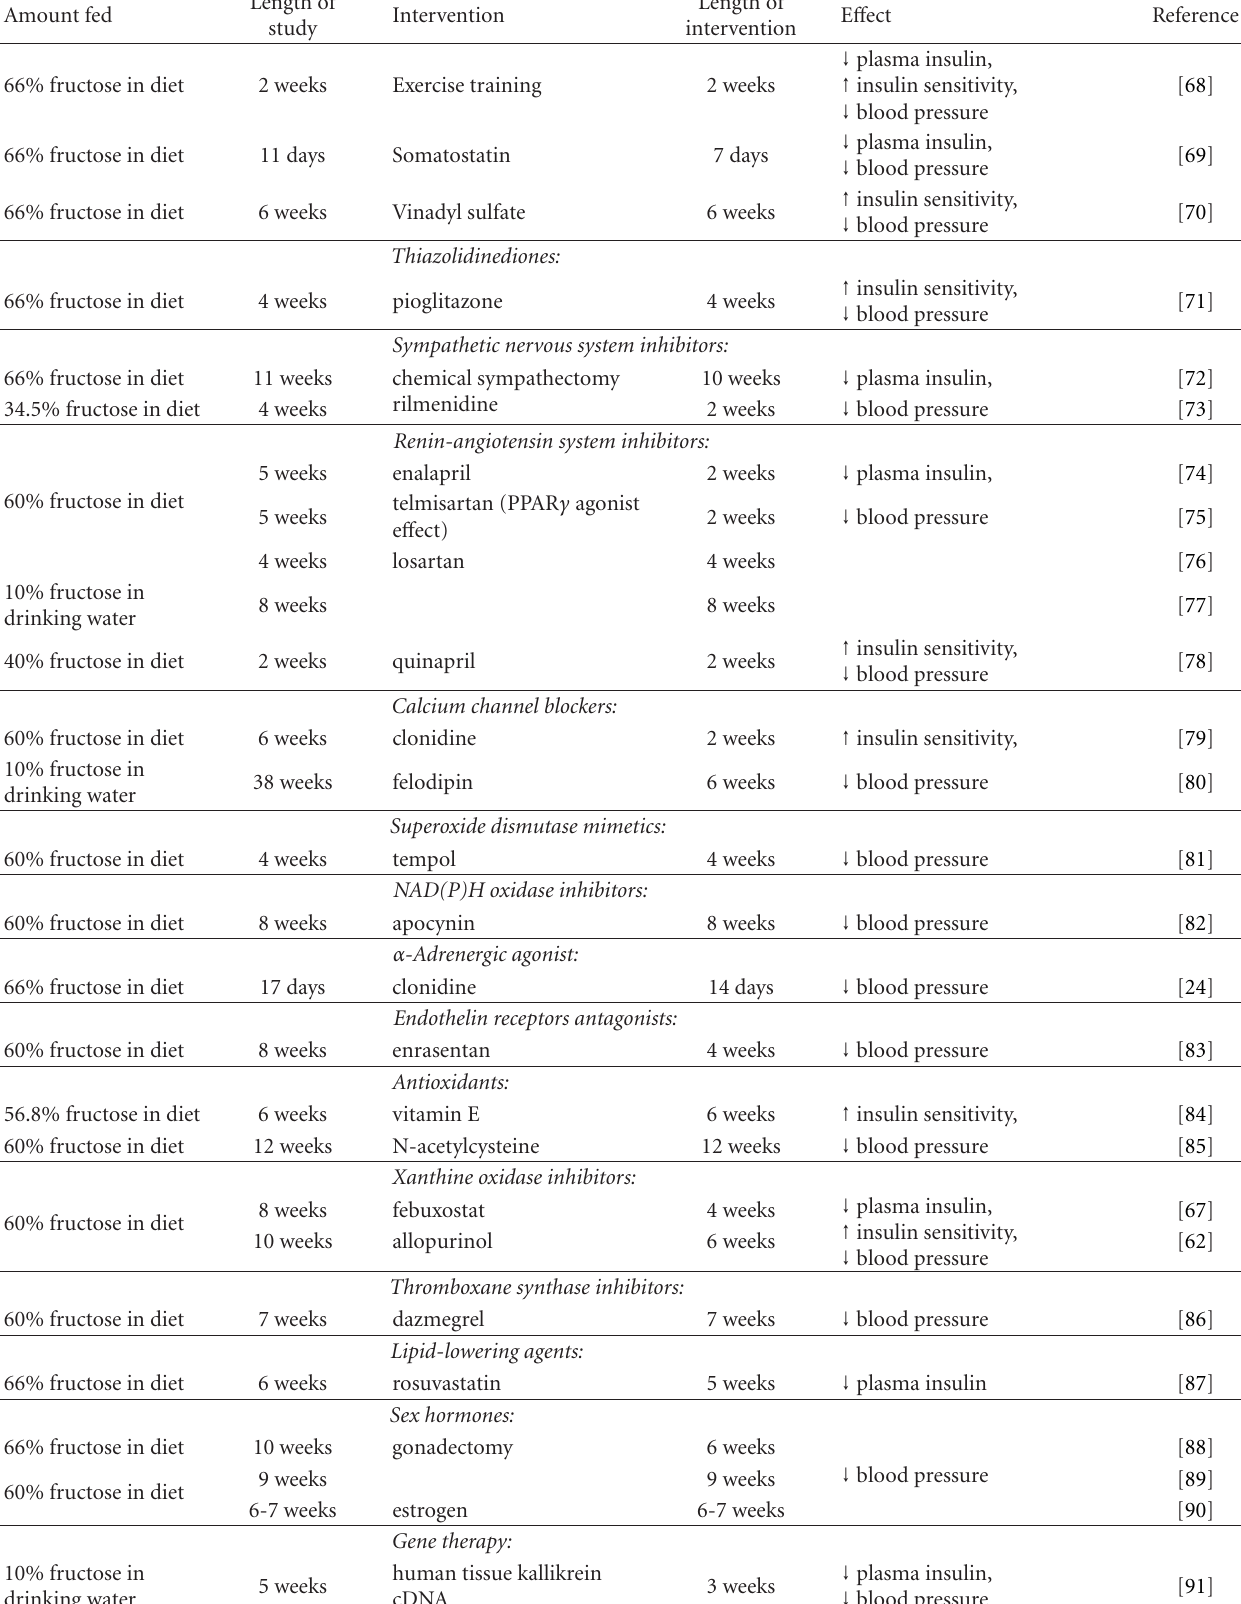
Length of E ff ect